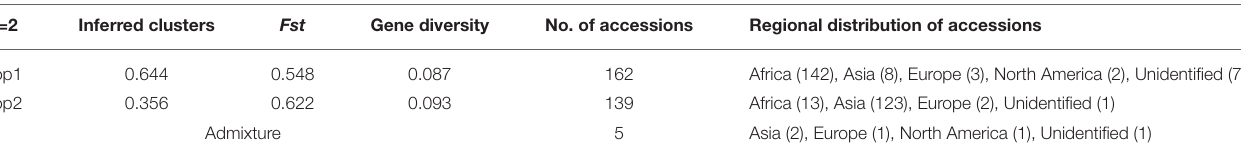
TABLE 5 | Gene diversity and Fst of the finger millet diversity panel for the two STRUCTURE -based populations. K = 2 Inferred clusters Fst Gene diversity No. of accessions Regional distribution of accessions Pop1 0.644 0.548